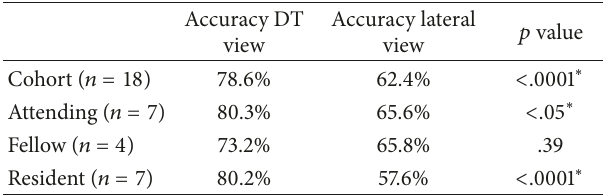
Table 1: Cohort and subgroup accuracy in the identification of screw prominence using either the DT or lateral